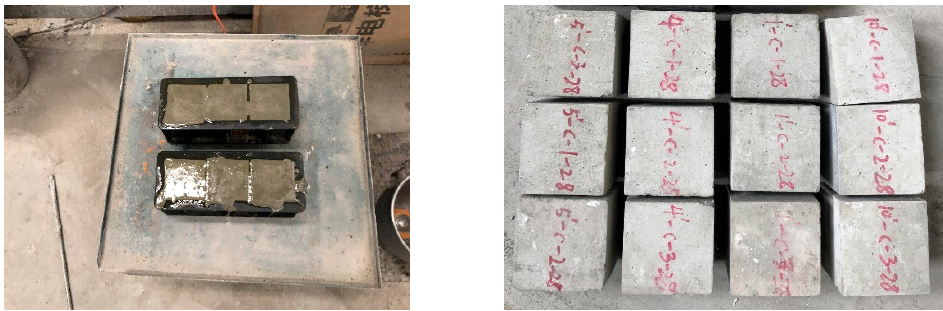
Figure 1. Specimen preparation of cement-based grouting material.